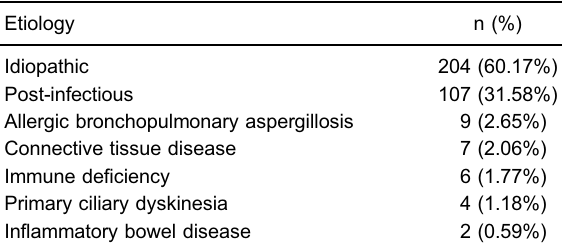
Table 1. General characteristics of 339 patients with non-cystic fi brosis